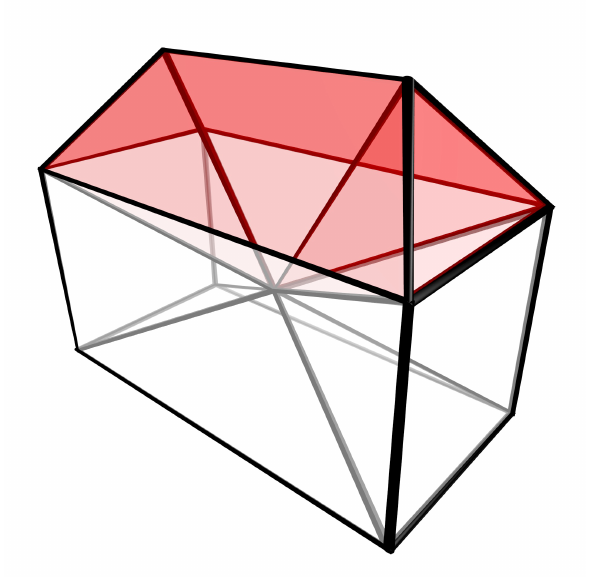
Figure 7: Collapsing a facet consisting of the volume of a simple 3D model of a house in 4D. As in Figure 2, the fourth dimension corresponds to an inwards-outwards axis due to the stereographic projection that is used.